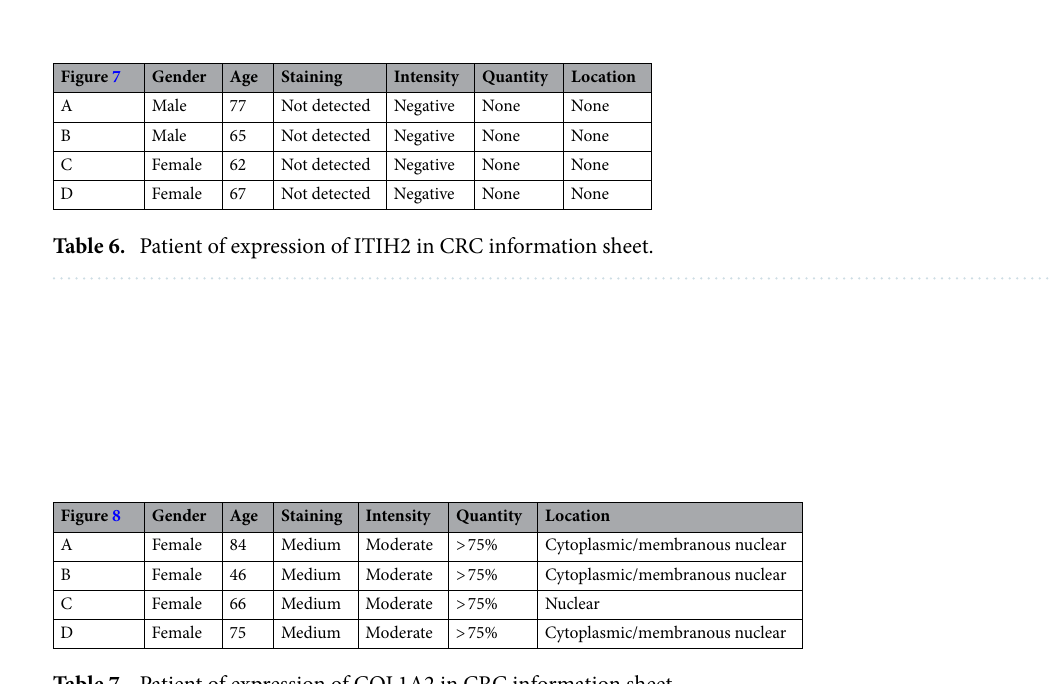
Table 7. Patient of expression of COL1A2 in CRC information